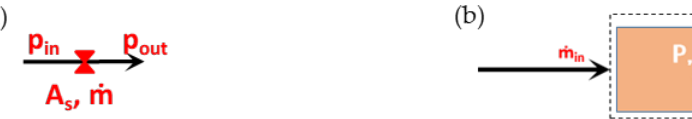
Figure 3. Calculation schematic of ( a ) mass flow rate and ( b ) Aerodynamic Parameters.